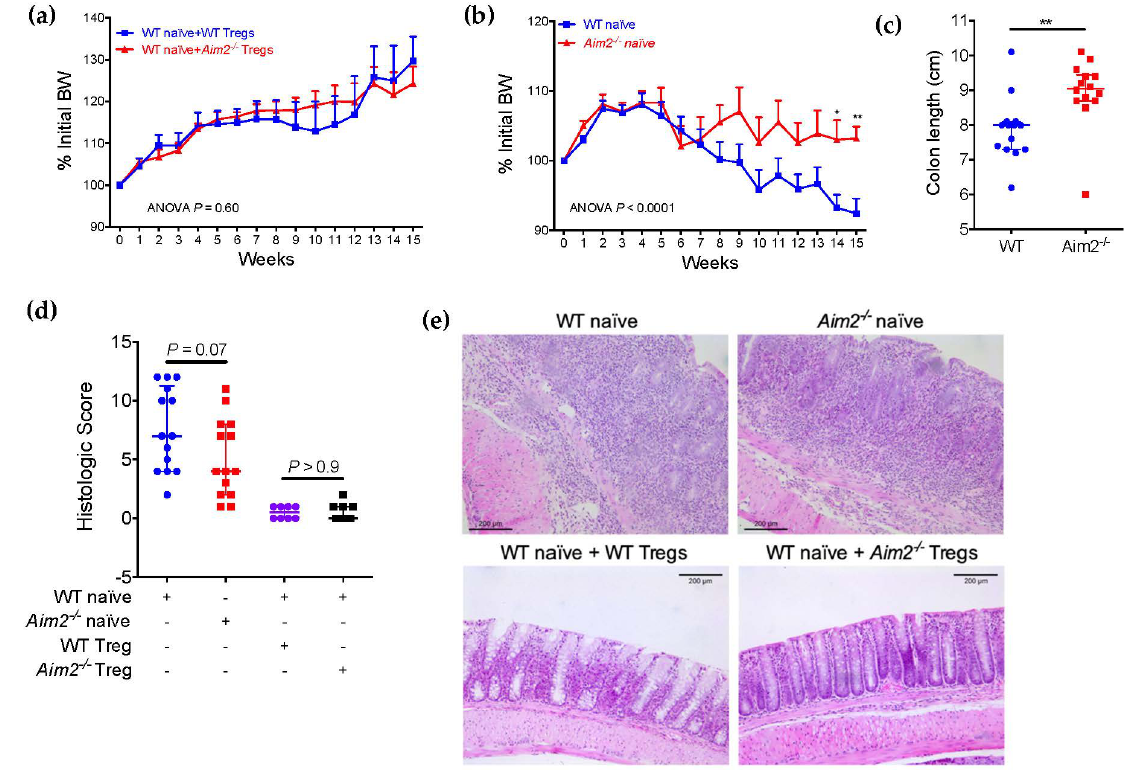
Figure 4. Aim2 −/− naïve T cells induce less body weight loss in the adoptive transfer model. Rag1 −/− recipient mice were transferred with FACS-sorted naïve CD4 + T cells (CD4 + CD45RB high CD25 - ) from WT ( n = 14) or Aim2 −/− ( n = 14) mice. Cotransfer groups received WT naïve T cells plus CD4 + CD45RB low CD25 + regulatory T (Treg) cells from either WT ( n = 8) or Aim2 −/− ( n = 10) mice. Mice were then monitored for colitis induction and sacrificed 15 weeks after transfer. ( a , b ) Percentages of initial body weight (BW) in the cotransfer groups ( a ) or in the Rag1 -/- mice transferred only with naïve T cells from WT or Aim2 −/− donors ( b ). ( c ) Measurement of colon length in mice transferred with naïve T cells from WT or Aim2 −/− donors. ( d ) Quantification of the histopathologic score of colitis in each group of mice. ( e ) Hematoxylin and eosin staining of colons from each group of recipient mice (original magnification, ×10). Scale bars represent 200 µ m. ( a , b ) Data are from one experiment representative of two independent experiments. ( c , d ) Pooled data from two independent experiments. Note: * p < 0.05, ** p < 0.01. Data were analyzed using a two-way ANOVA with Holm–Sidak multiple comparison test and are displayed as mean ± standard deviation ( a , b ), or using a Mann-Whitney U test and displayed as median ± interquartile range ( c , d ).